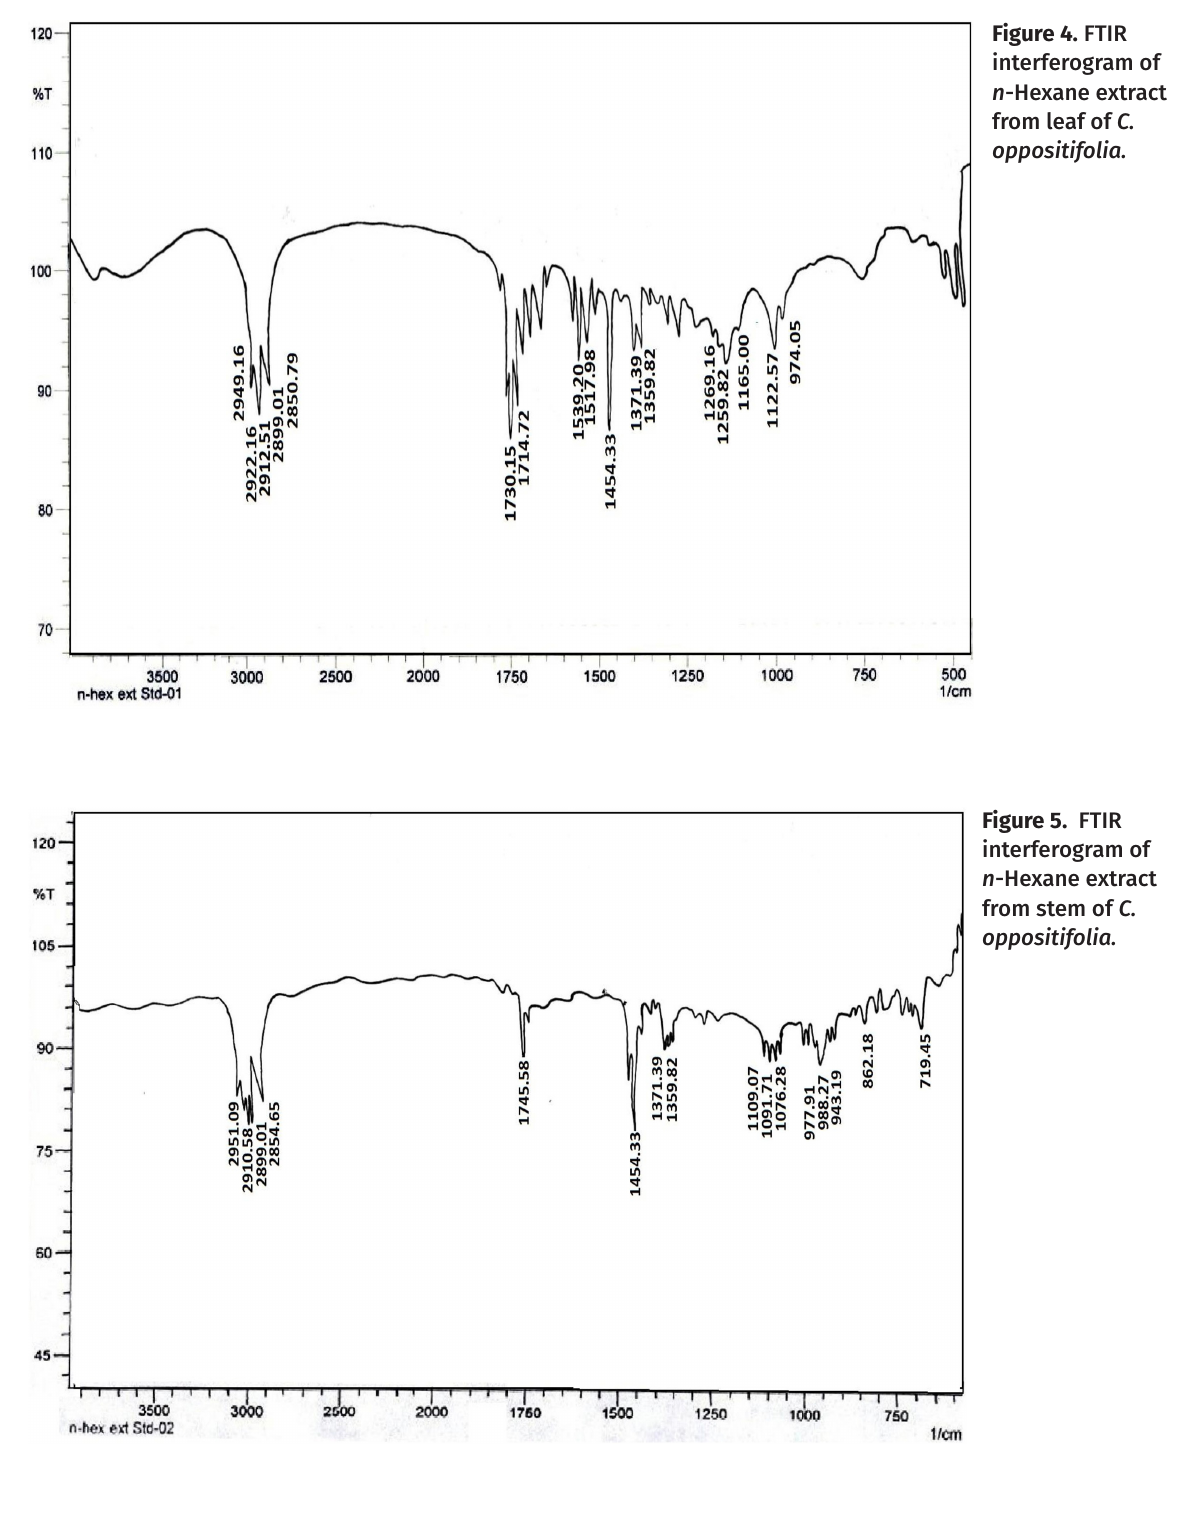
Figure 4. FTIR interferogram of n -Hexane extract from leaf of C. oppositifolia.